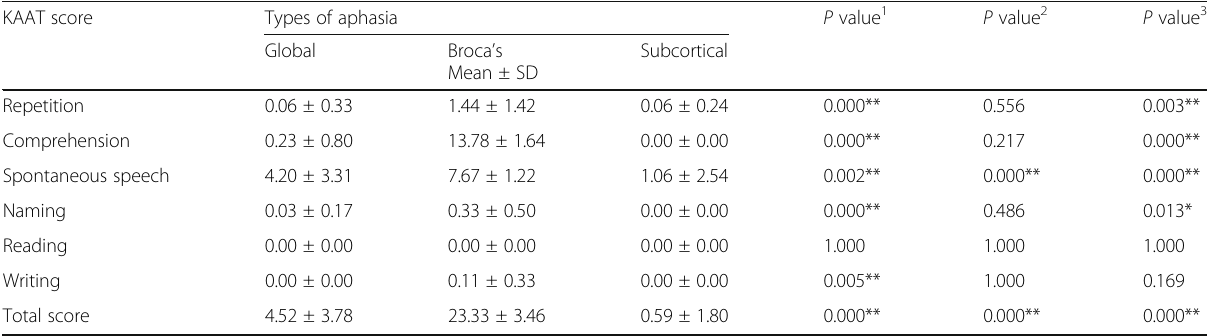
Table 4 Comparing KAAT score at onset between the most frequent aphasia subtypes (global, Broca ’ s, and